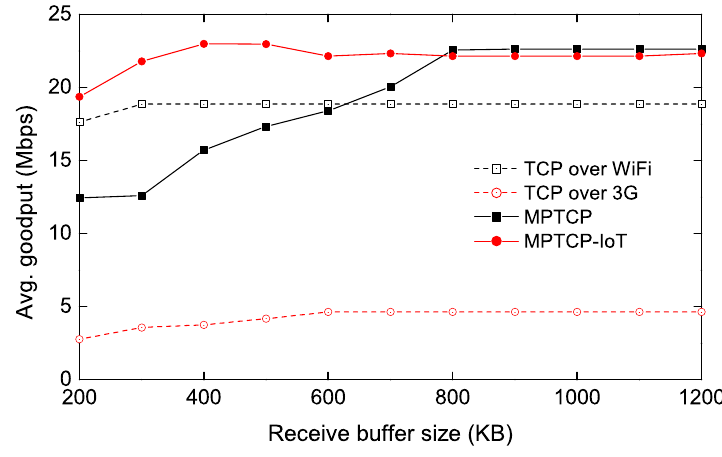
Figure 4. Throughput measurement as a function of receive-buffer size of IoT